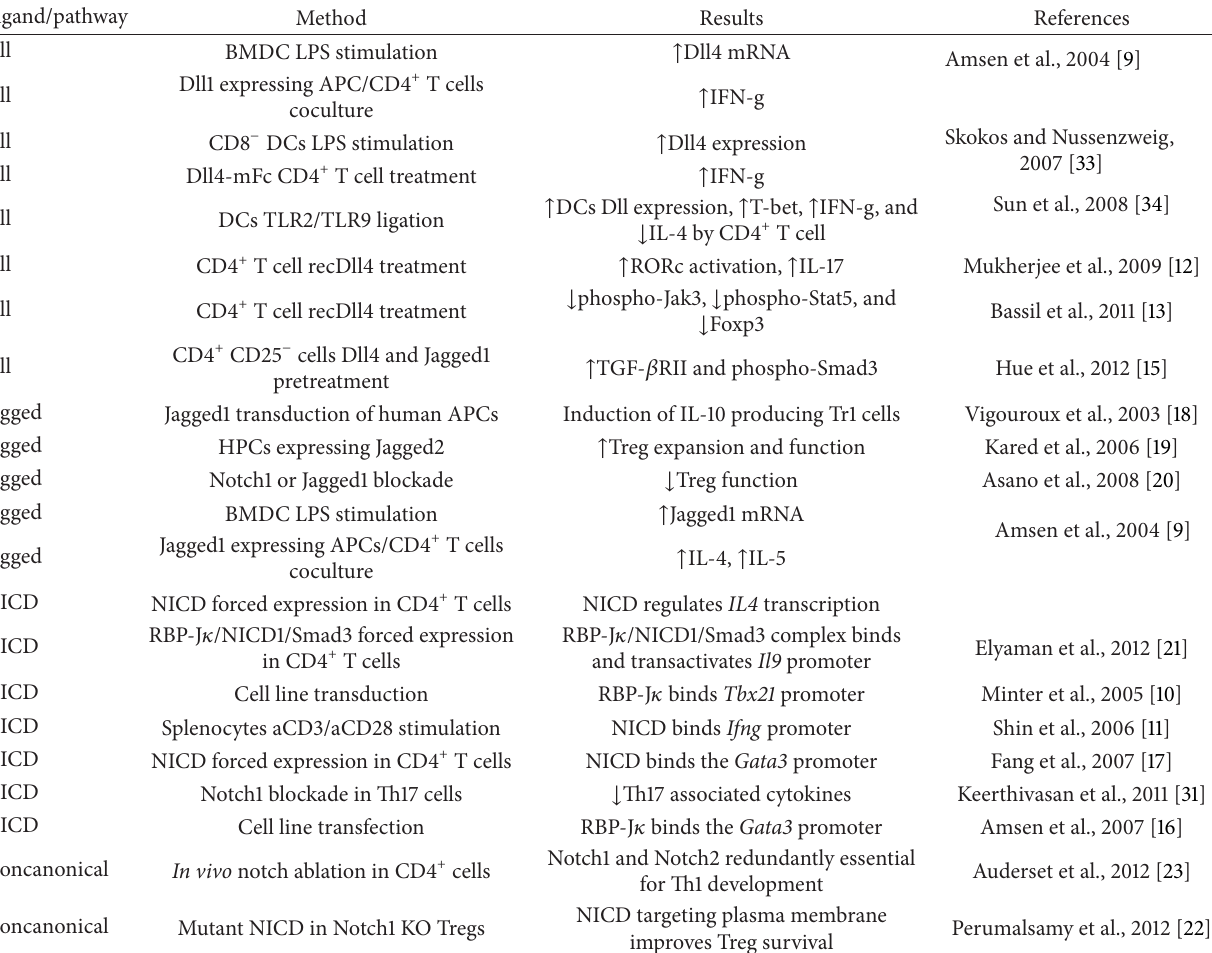
Table 1: Notch and Th subsets.